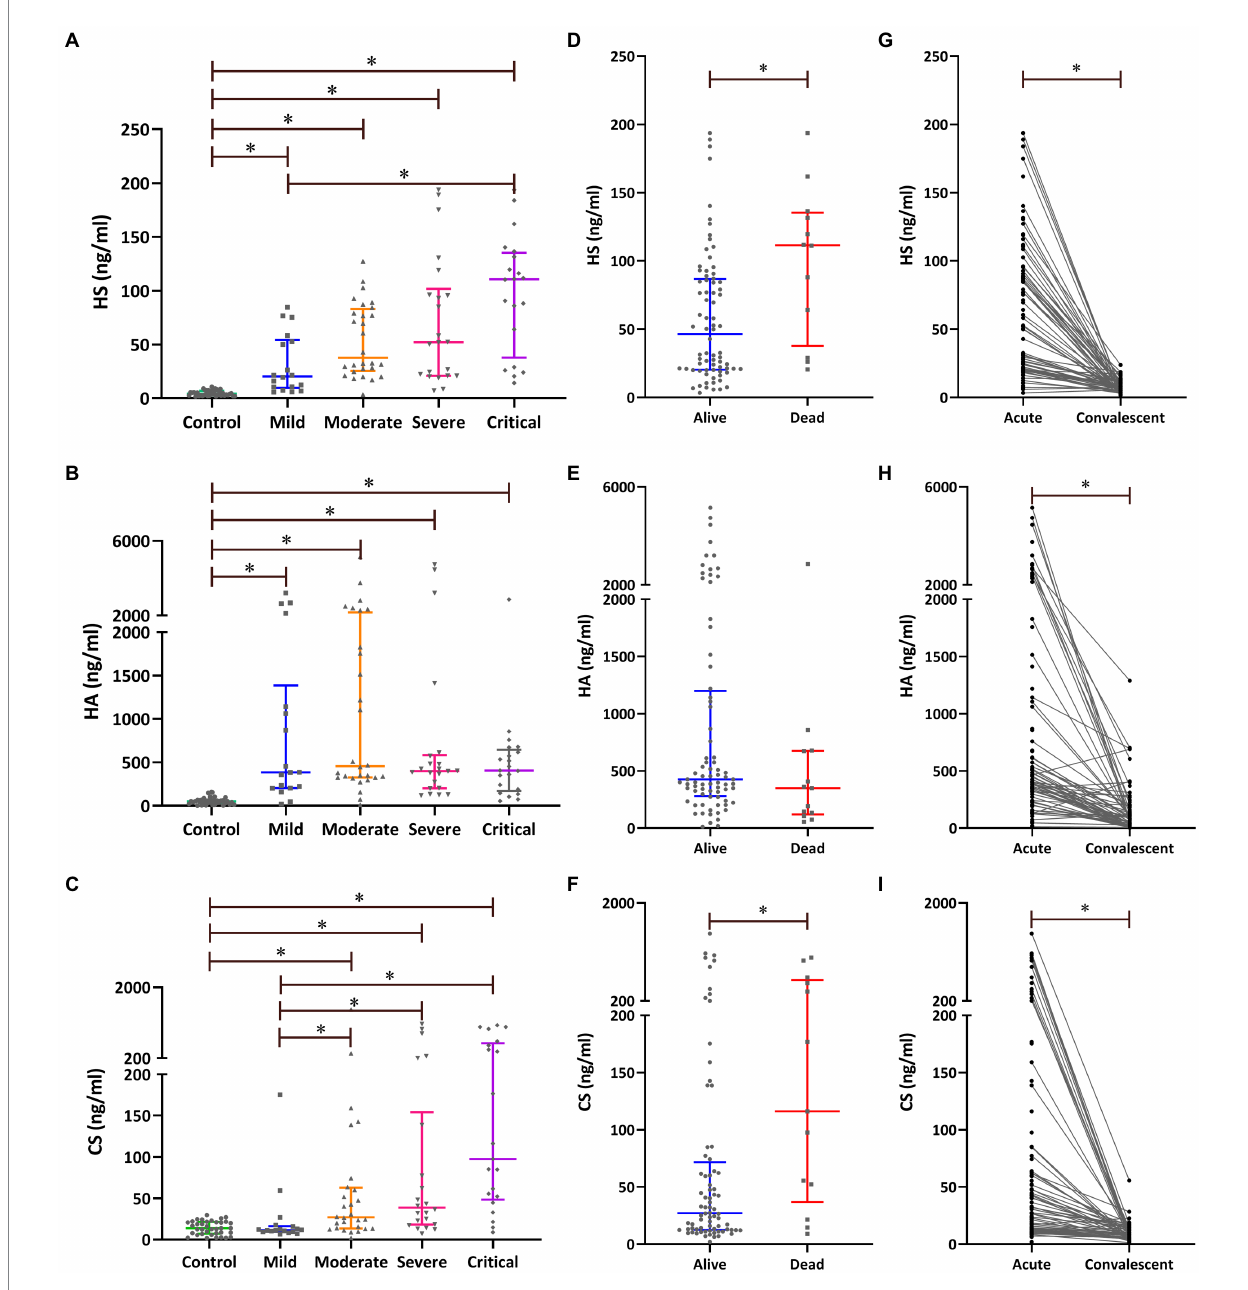
FIGURE 1 Plasma levels of exfoliated glycocalyx components [heparan sulfate (HS), hyaluronic acid (HA), and chondroitin sulfate (CS)] in patients with HFRS. The levels of plasma HS (A) , HA (B) , and CS (C) during the acute stage were compared using the Kruskal–Wallis H -test; pairwise comparisons among the five groups were performed using the Nemenyi rank test. The levels of plasma HS (D) , HA (E) , and CS (F) during the acute stage were compared between the survivors and non-survivors using the Mann–Whitney U -test. The differences in plasma HS (G) , HA (H) , and CS (I) between the acute and the convalescent stages were compared using the Wilcoxon matched-pairs signed-ranks test. * p <